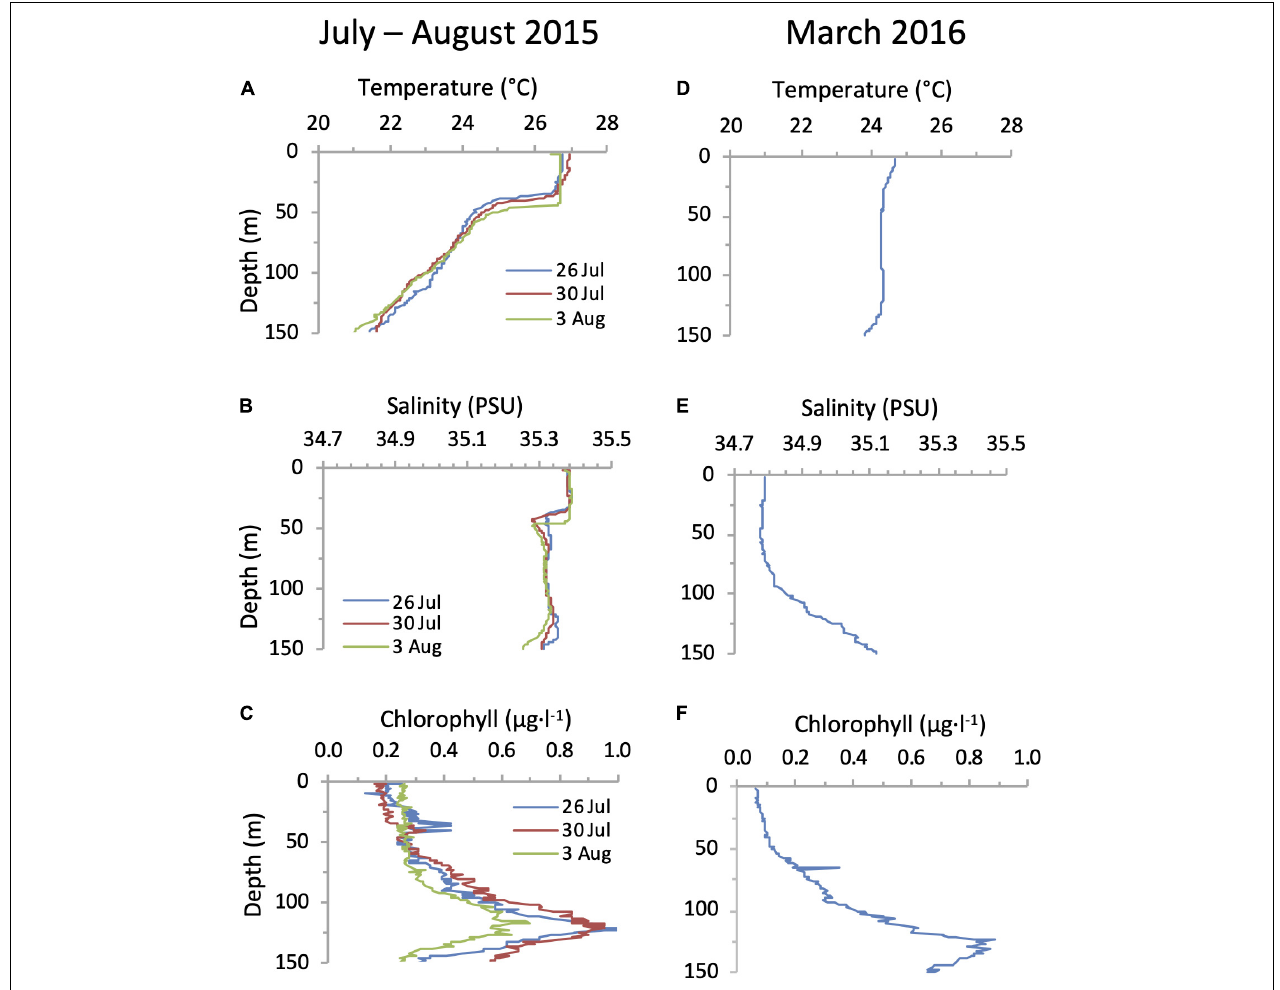
FIGURE 4 | Water column conditions in the NPSG. Depth profiles of temperature (A,D) , salinity (B,E) and chlorophyll (C,F) during the summer cruise in July–August 2015 (left panels) and in the spring cruise on the 24 March 2016 (right